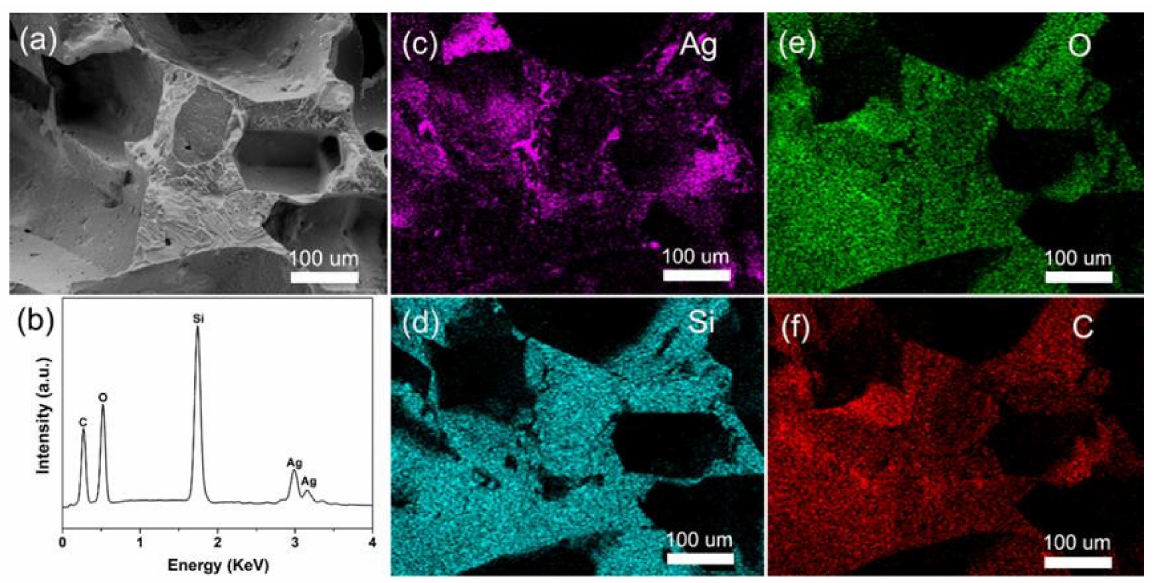
Figure 5. ( a ) SEM image of the P-3 PAP sponge. ( b ) Energy dispersive spectroscopy of the PAP sponge. Element maps were generated of silver ( c ), silicon ( d ), oxygen ( e ), and carbon ( f ).